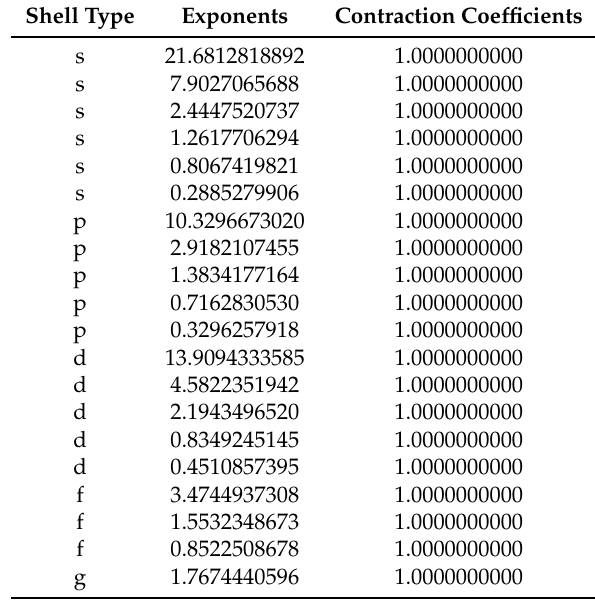
Table A21. Parameters of the cc-TZVP auxiliary basis set of Nitrogen. Parameters taken from [89].